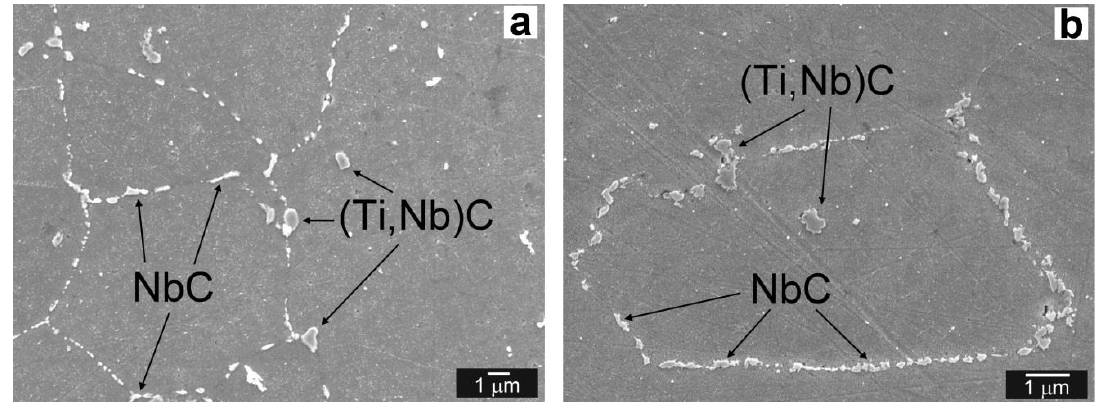
Figure 3. Microstructural characterization of the T92 base material (BM) region in different material states: QT PWHT ( a ); QT PWHT + 620 °C/2500 h ( b ) with typical EDX spectrum of Fe 2 (W,Mo) based Laves phase precipitates ( c ) and distribution of coarse Laves phase particles visualized in secondary electrons (SE) mode and back-scattered electrons (BSE) mode ( d ).